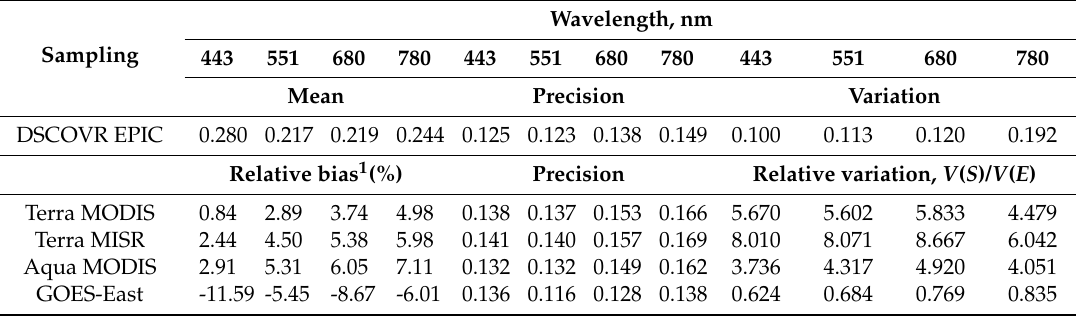
Table 3. Statistical characteristics of scattering function for 23 August